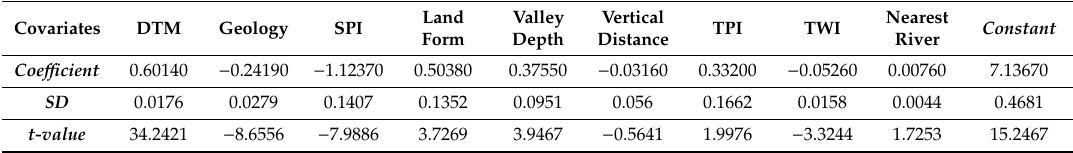
Table 2. The calculation results of the coefficient after eliminating gravity disturbance and outliers from the input data (estimation 2).